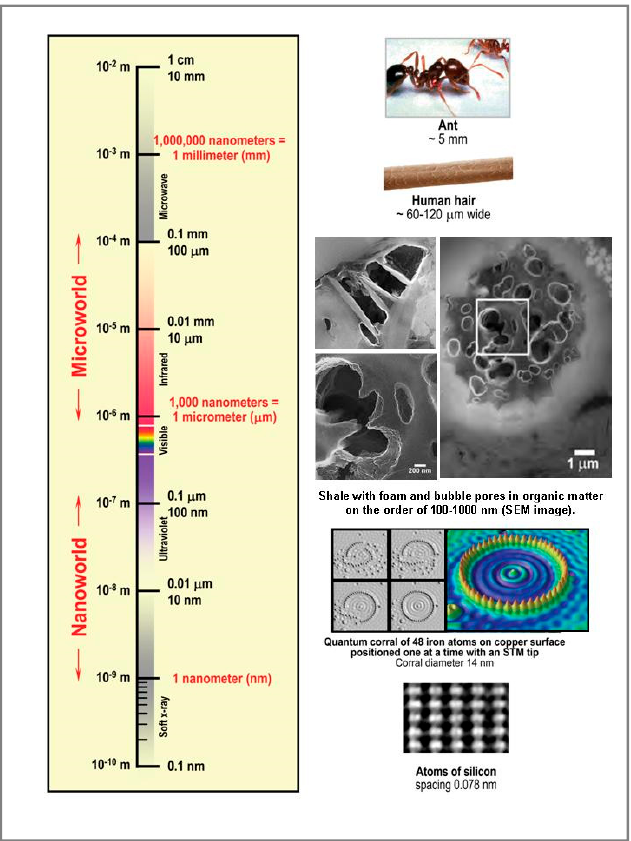
Figure 1. Augment scale of things with images of rock porosity diameters covering the same range. Adapted from [21]. SEM images from [11].